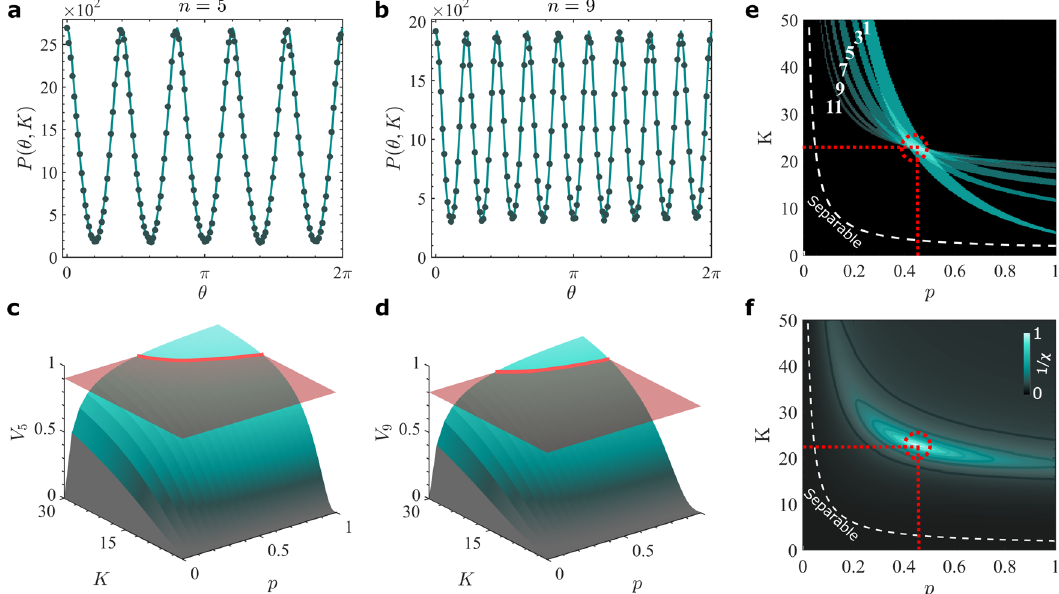
Fig. 2 Visibility, dimensionality and purity. Experimental (points) and theoretical (solid lines) coincidence count rates resulting from projections of photons A and B onto the states M ; θ j i n and (cid:2) M ; 0 j i n , respectively, as a function of the relative orientation angle θ for a n = 5 and b n = 9. Theoretical visibility as a function of the dimensionality ( K ) and purity ( p ) for c n = 5 and d n = 9, exemplifying it increases monotonically with both parameters. The (red) planes intersecting the curves are the experimental visibilities, with the possible solution space for each shown as a red trajectory. The resulting trajectories for n = 1, 3, ..., 11 are shown in ( e ), where the thickness of each is due to the uncertainty in the visibility outcome. The dimension and purity of the system are found where they coincide, shown as a dashed red circle. f The latter corresponds to the optimal ( p , K ) that minimise the function χ 2 ( p , K ), ffiffiffiffiffiffiffiffiffi p or, equivalently, maximises 1 = χ 2 , where the minimum of χ 2 is now shown as a peak corresponding to ( p , K ) = (0.45 ± 0.03, 22.84 ± 0.62). The critical bound, p ≤ 1/( K + 1), separating entangled and separable states is marked by the white dashed